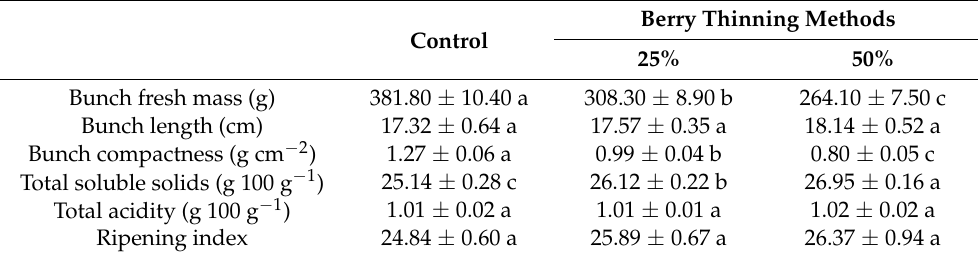
Table 2. Effects of berry thinning methods on parameters related to bunch architecture and berry chemical quality at harvest in the 2019 growing season 1